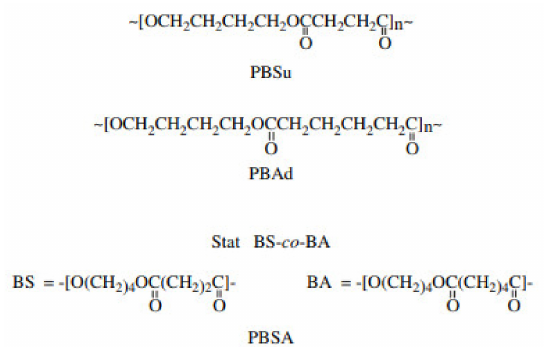
Figure 7. Structure of homopolyesters poly(butylene succinate) (PBSu), poly(butylene adipate)(PBAd) and copolyesters poly(butylene succinate-co-butylene adipate) (PBSA) via polycondensation pro- cess [55]. Adapted with permission from D í az et al.